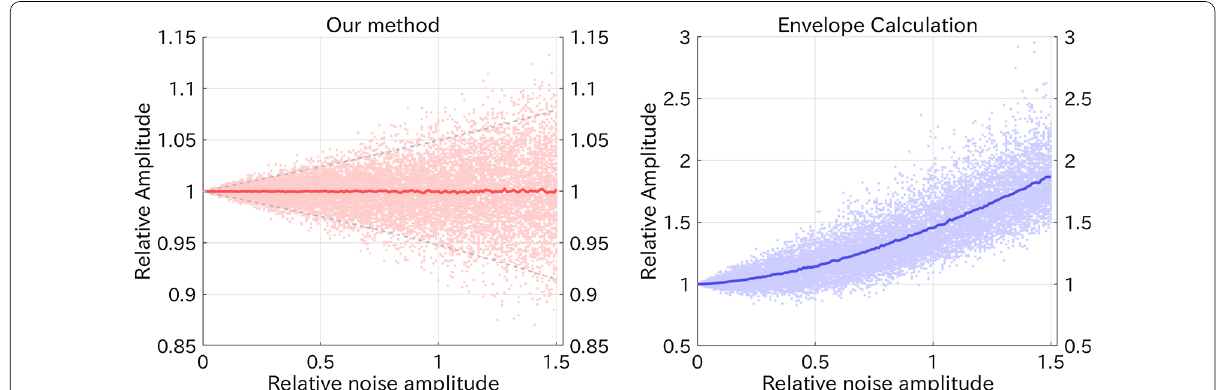
Fig. 2 Result of the performance test. Amplitudes estimated using our method and the envelope calculation are shown by the dots in the left and right panels, respectively. Horizontal axes indicate the amplitude of noise relative to the root mean square of the signal. Vertical axes indicate the amplitude estimated with each method. The bold line shows the average of the calculation for each noise amplitude. The gray dashed line in the left panel indicates 95% confidence intervals, which are theoretically estimated from the noise